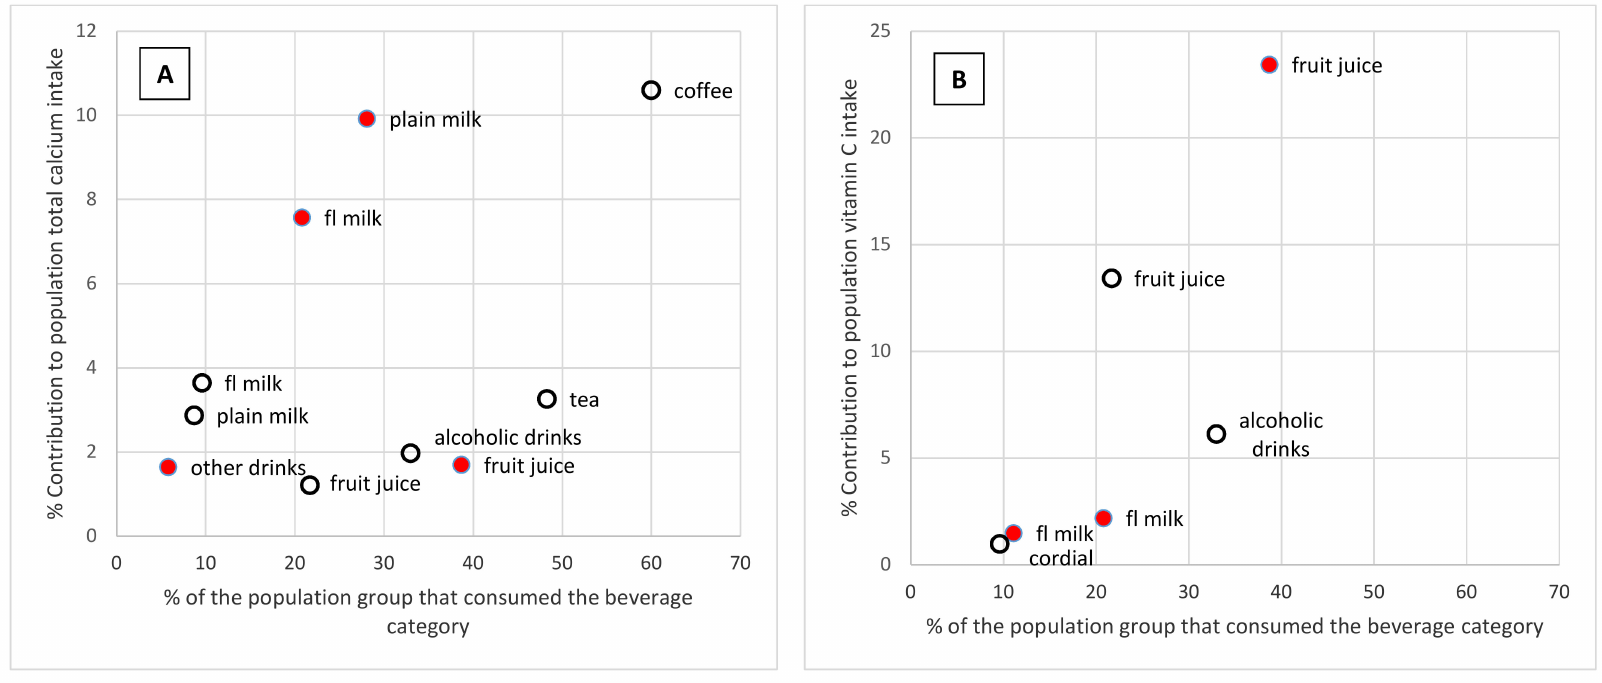
Figure 4. The contribution of beverage categories to ( A ) total dietary calcium intake and ( B ) total dietary vitamin C intake for Australian children (2 to 18 years, ) and adults (19 years and older, ) by the prevalence of consumption on the day of the survey. Only categories contributing 1% or more to the total nutrient intake are